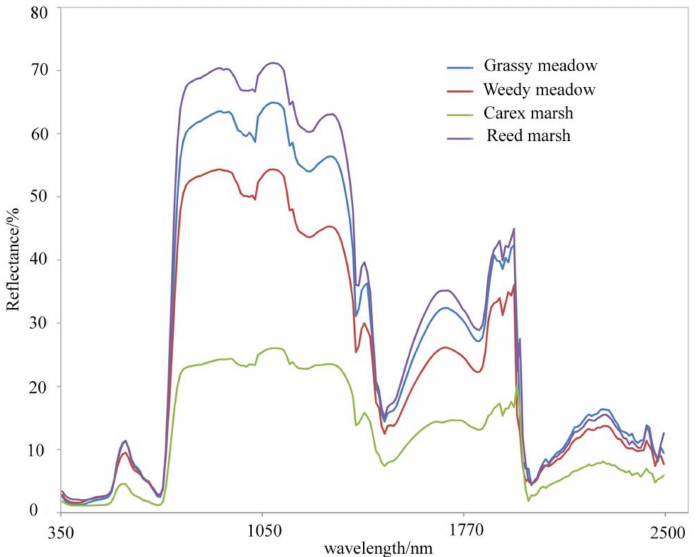
Figure 3. Procedure of the sparse constrained least square linear spectral mixture